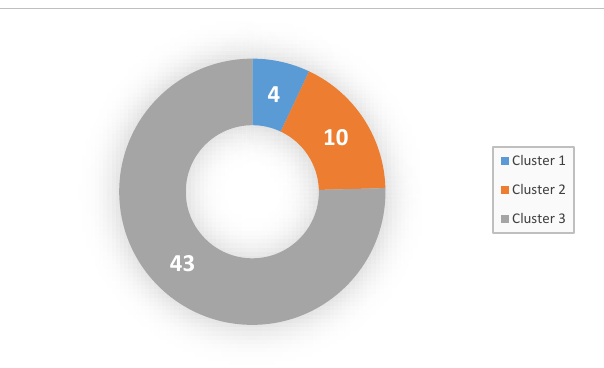
Figure 3. Clusters according to the GDPR transitional